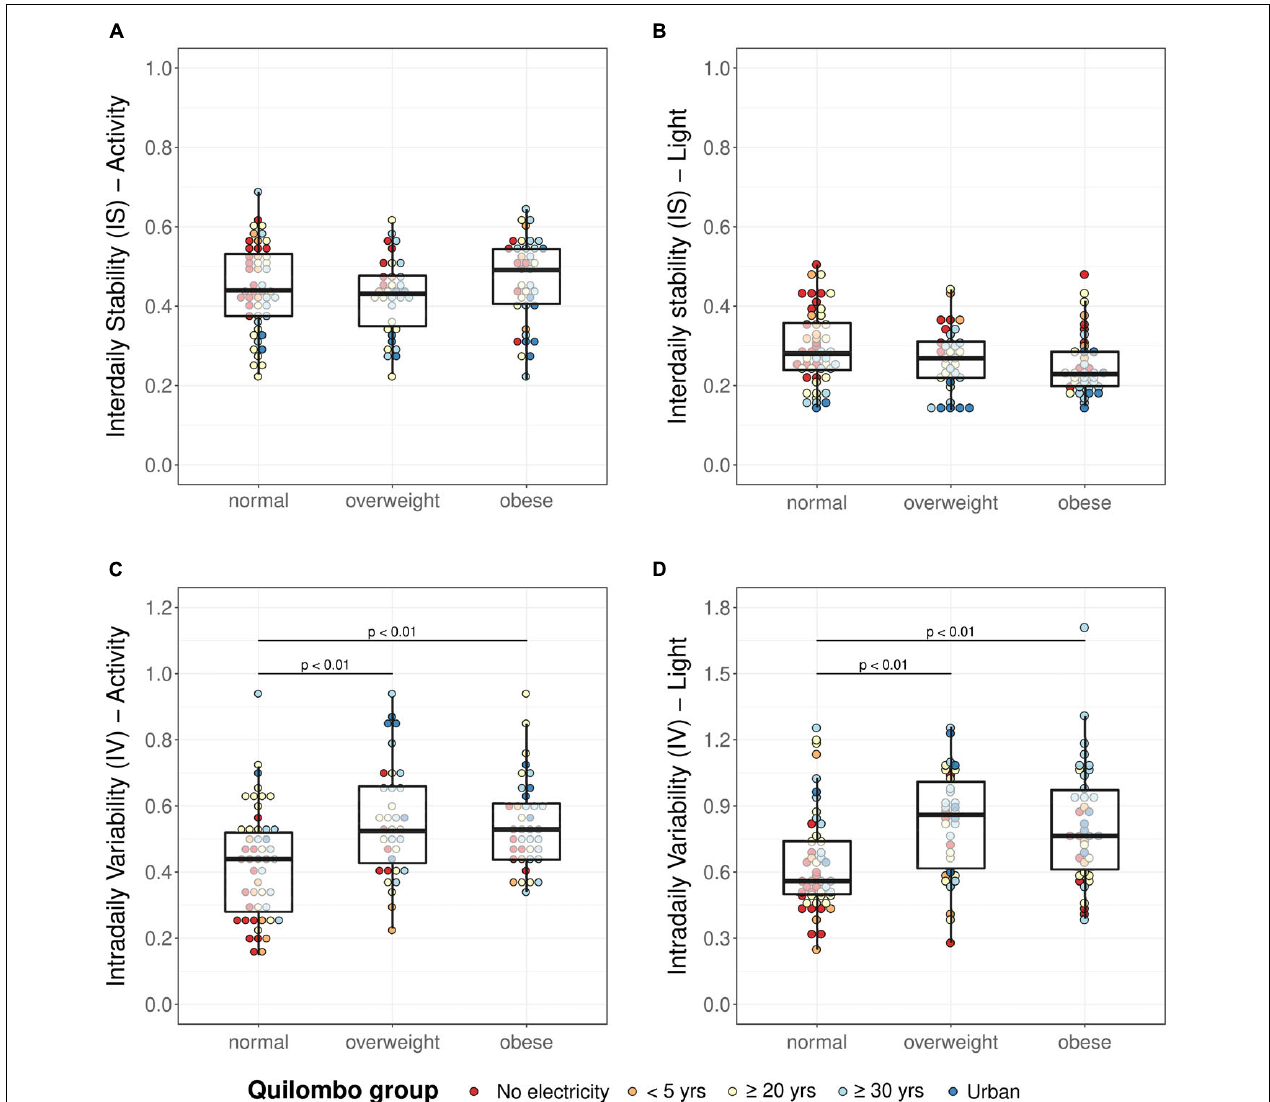
FIGURE 3 | Activity IS (A) , activity IV (C) , light IS (B) , and light IV (D) in normal-weight, overweight, and obese groups. Analyses were performed using the Kruskal–Wallis test followed by Dunn’s test. IS, Interdaily stability; IV, intradaily variability; p -values according to Dunn’s test for multiple comparisons, adjusted with Sidak